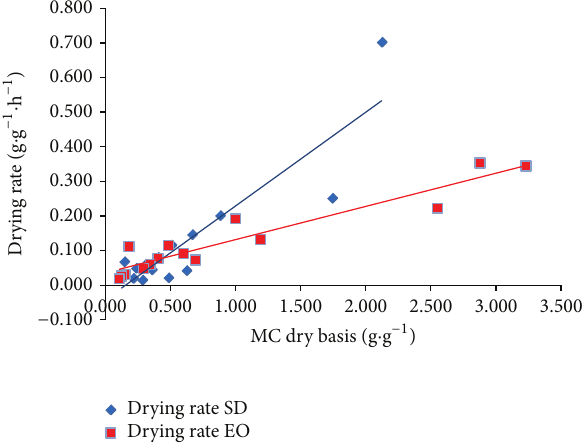
Figure 6: Drying rate curves of fish meat dried in solar dryer and electric oven.